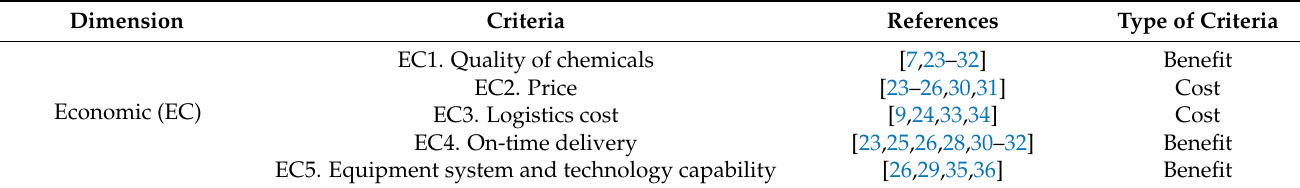
Table 1. Literature review summary of SSS evaluation